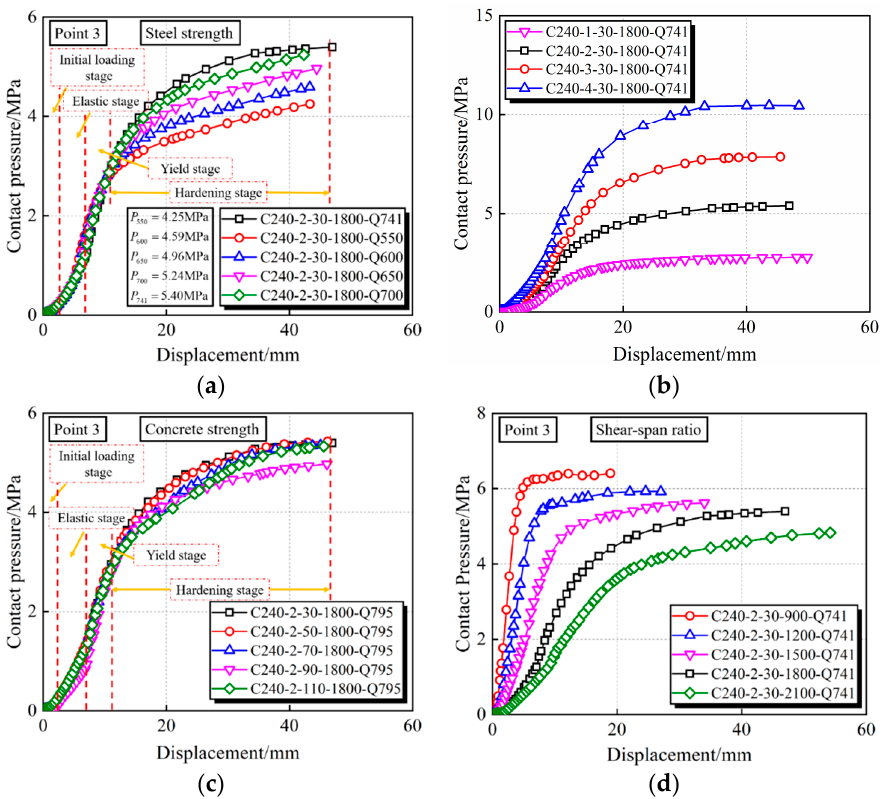
Figure 16. Influence on contact pressure. ( a ) Yield strength of steel tube; ( b ) D / t ratio; ( c ) Compressive strength of core concrete; ( d ) Shear ‐ span ratio.